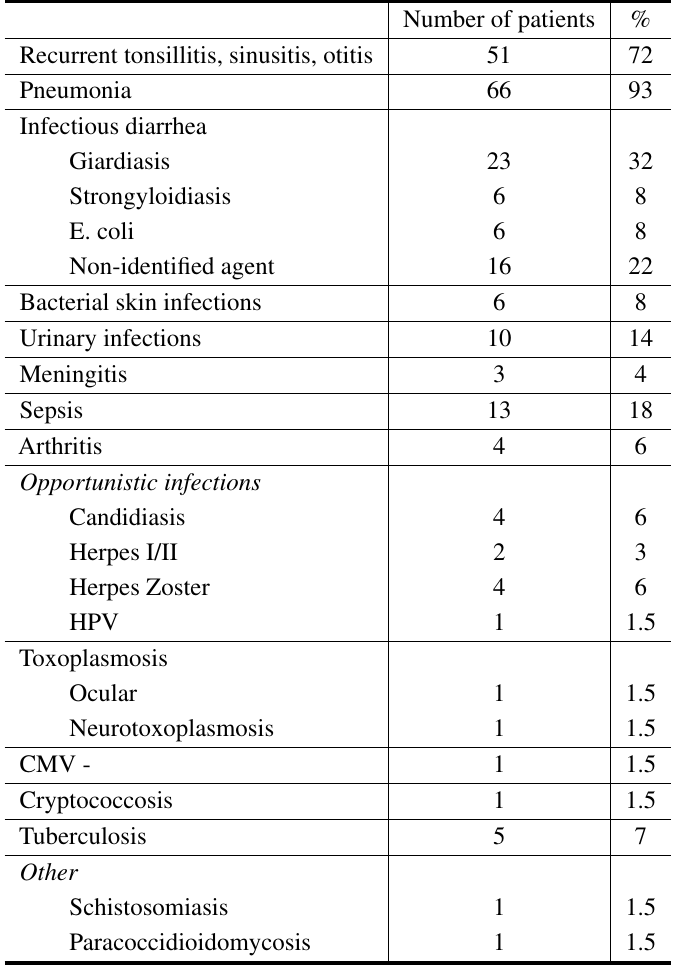
Most common infectious diseases in a cohort of Brazilian patients with CVID. Number of